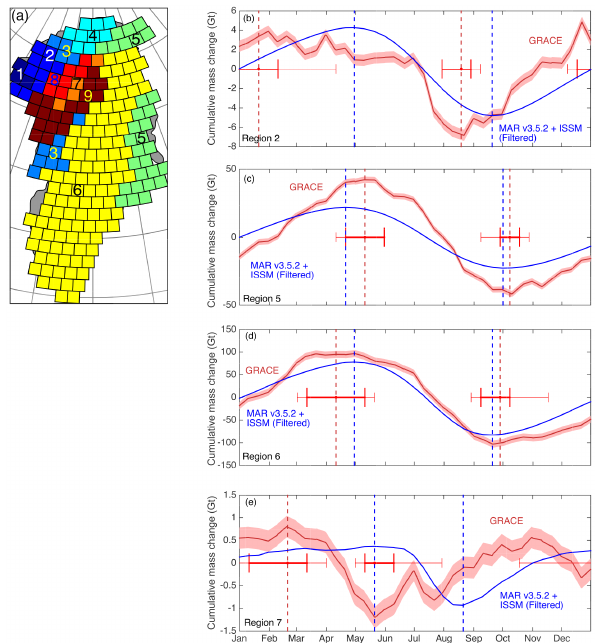
Figure 11. (a) GrIS regions defined based on the timing of peaks in the average cycle of detrended cumulative mass change from GRACE-LM. The average January 2003 to December 2012 sea- sonal cycle from MAR v3.5.2 + ISSM and GRACE-LM is also shown for selected regions: (b) Region 2, (c) Region 5, (d) Re- gion 6, and (e) Region